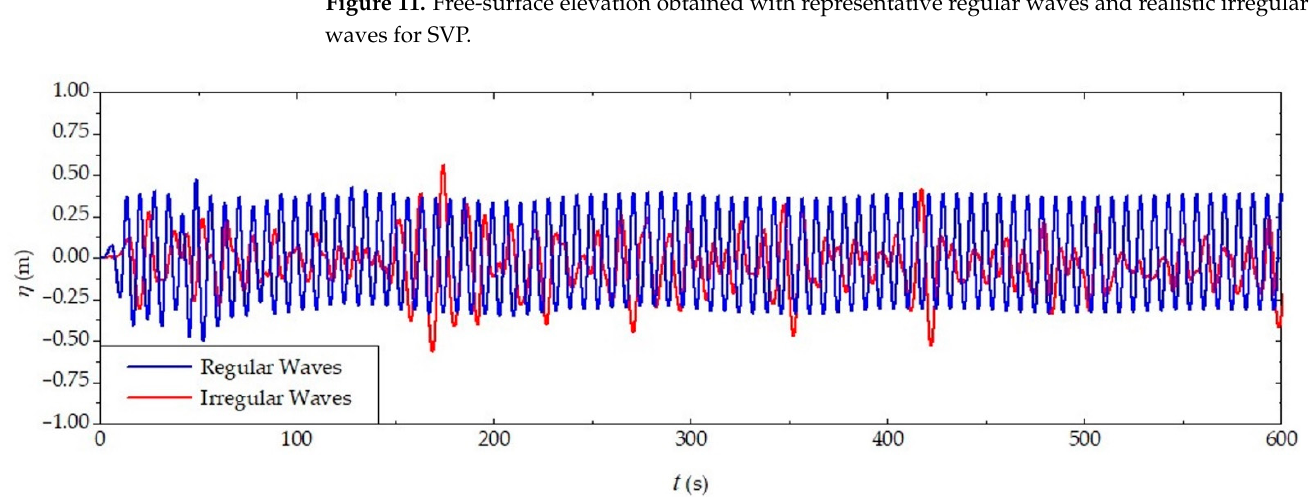
Figure 12. Free-surface elevation obtained with representative regular waves and realistic irregular waves for TV.